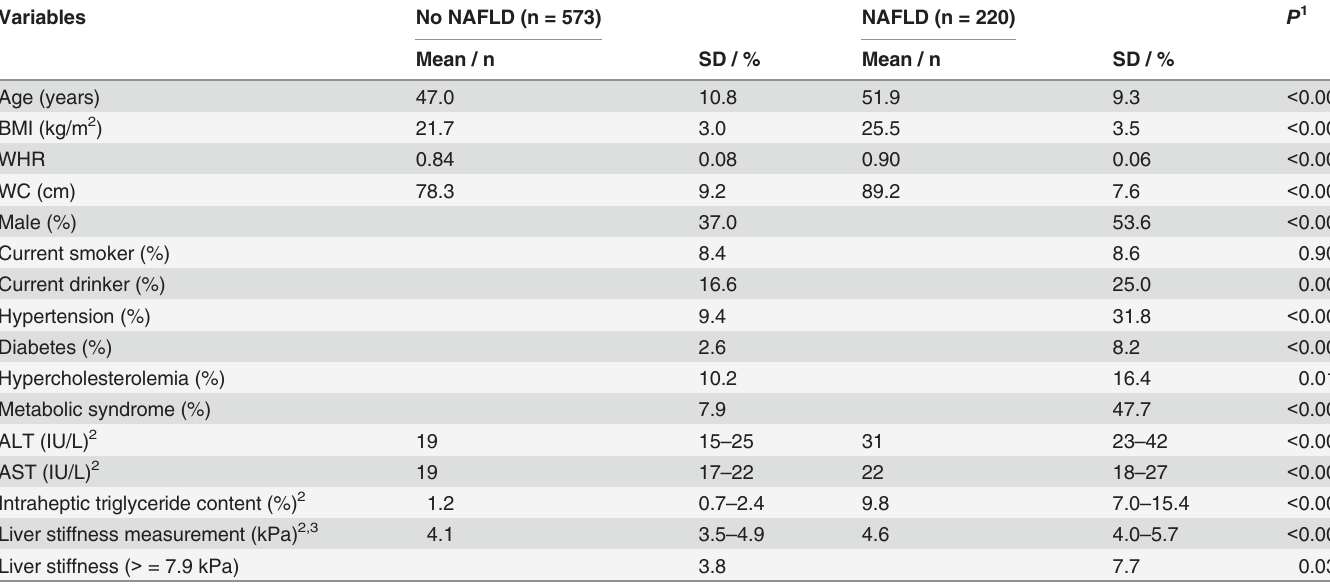
Table 1. Baseline characteristics between subjects with and without NAFLD (n =